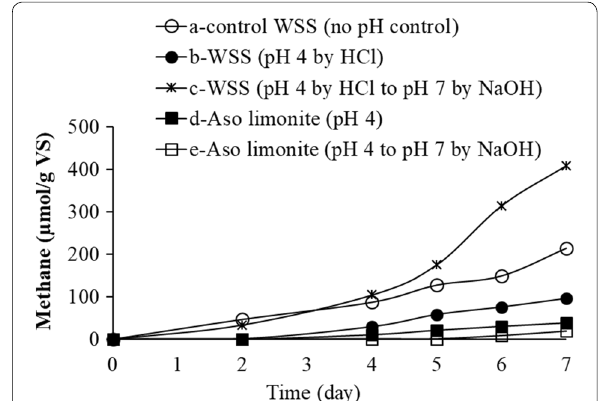
Fig. 2 pH effect in the inhibition of methane fermentation by Aso limonite. Since the addition of Aso limonite triggered to be at around pH 4, the following five WSS samples were prepared for the anaerobic digestion for 7 days: a—control WSS (no pH control), b—the pH of WSS was initially adjusted at pH 4 by adding HCl, c—the WSS at pH 4 was further readjusted at pH 7 by adding NaOH, d—Aso limonite was added to WSS, and e—the WSS with Aso limonite was readjusted at pH 7 by adding NaOH. The concentration of Aso limonite used in this experiment was 5% (w/v). Error bars represent the standard errors (n =